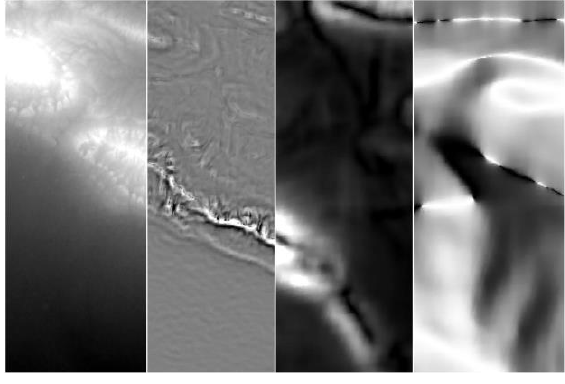
Figure 3. Example for SRTM terrain parameters: